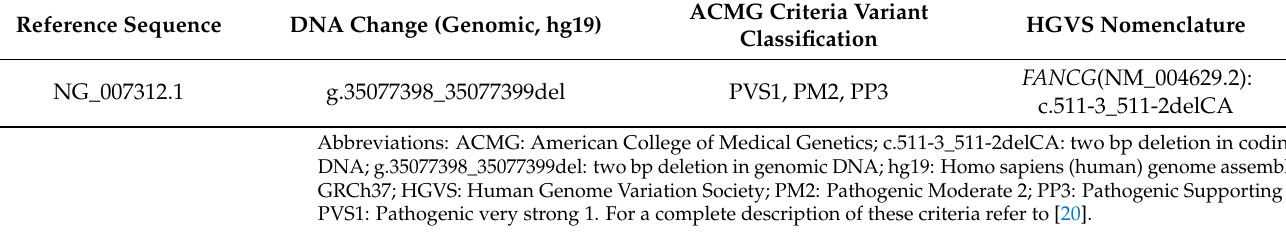
Table 1. Features of the pathogenic variant found in FANCG .